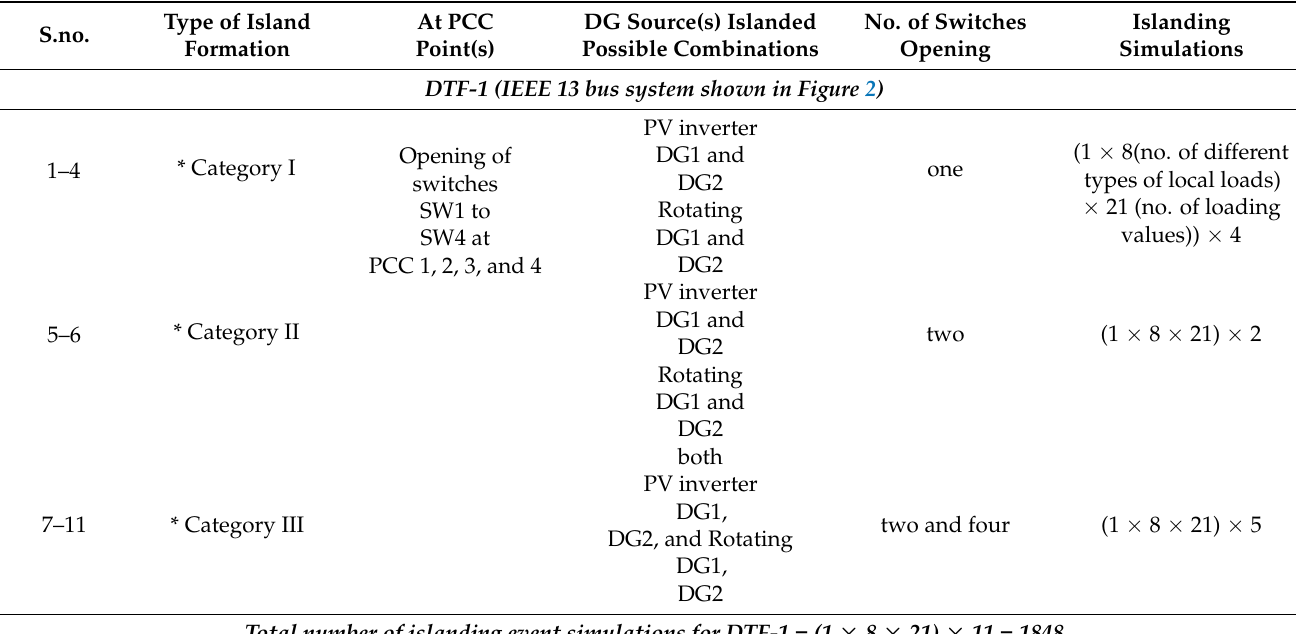
Table 3. Islanding switching events and the total number of